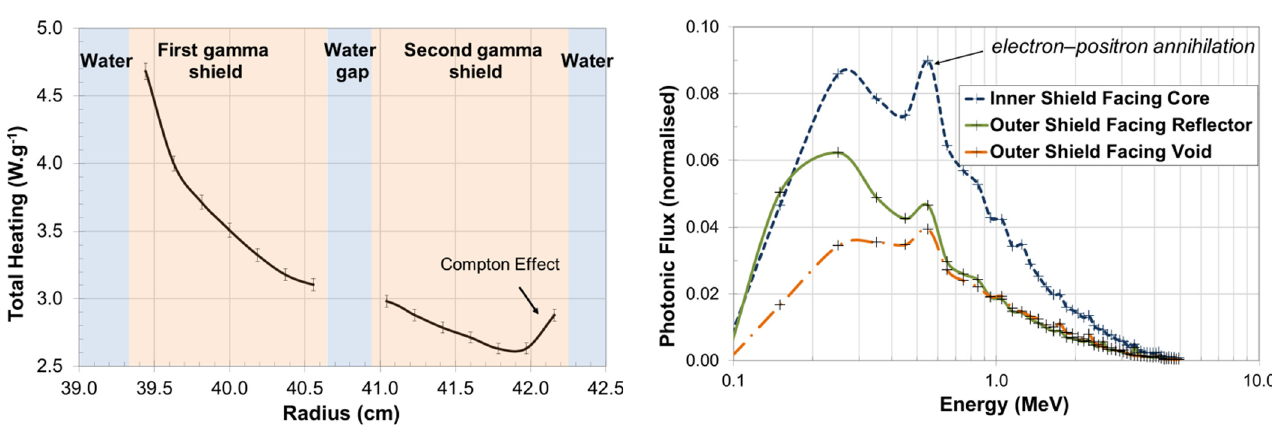
Fig. 6. Total heating in the gamma shield of P1 sector (along (cid:3) abscise). An increase of the energy deposition is found at the interface with the beryllium.